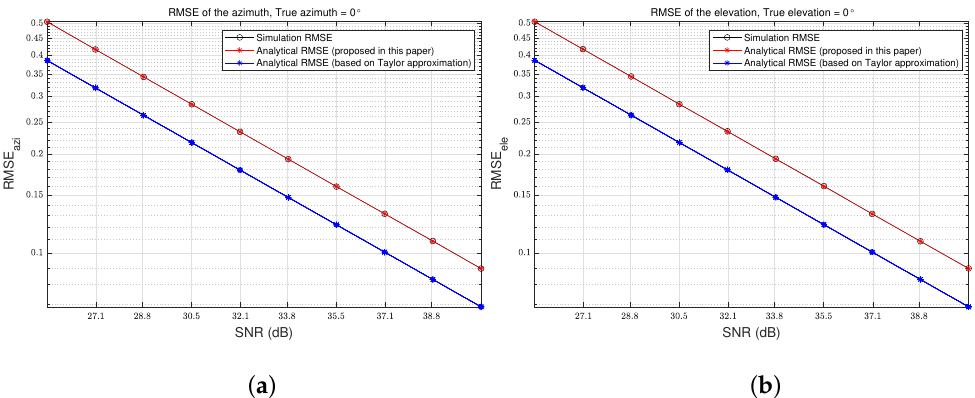
Figure 16. Comparison of RMSE results using analytic expression based on Taylor approximation and analytic expression based on numerical integration. ( a ) RMSE of ˆ θ azi . ( b ) RMSE of ˆ θ ele